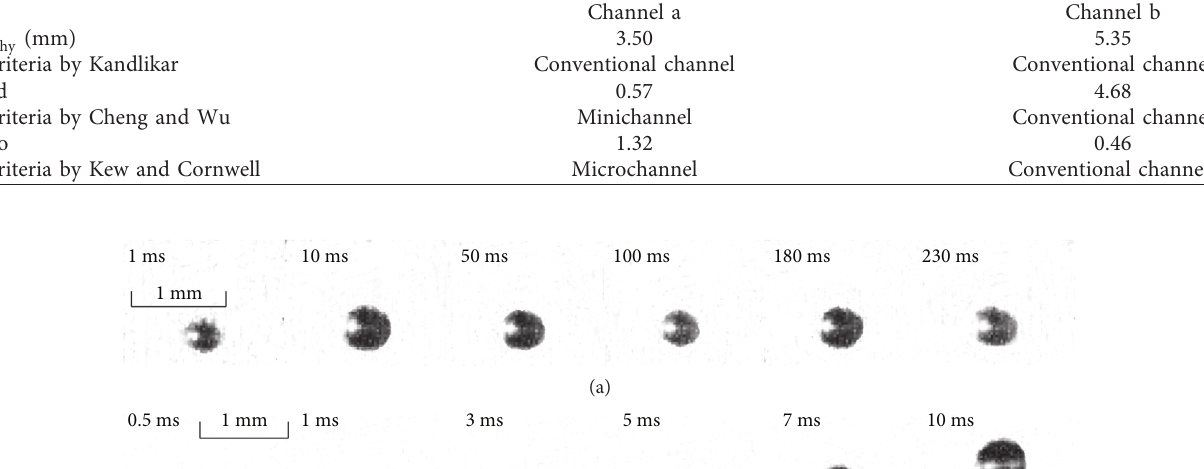
: 90 ° C, G : 100kg/(m 2 · s), p:1000W. in